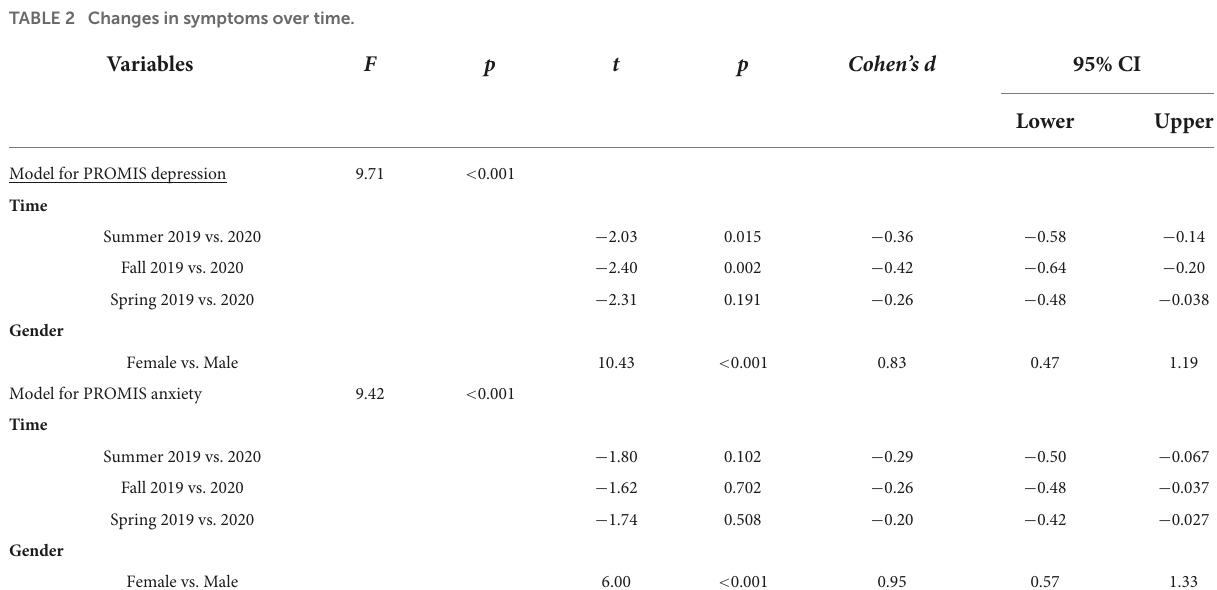
TABLE 2 Changes in symptoms over time.